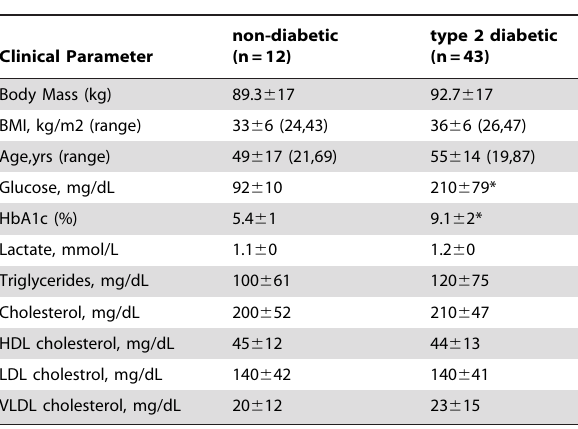
Table 2. Plasma non-esterified fatty acids ( m M) in BMI- matched obese non-diabetic and type 2 diabetic African- American